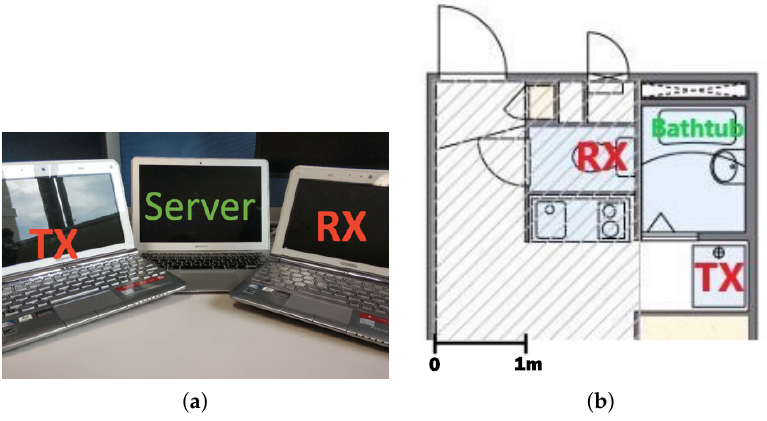
Figure 8. Experiment setup: ( a ) transmitter (TX), receiver (RX), and server used in our experiment, and ( b ) configuration of TX, RX, and bathtub.